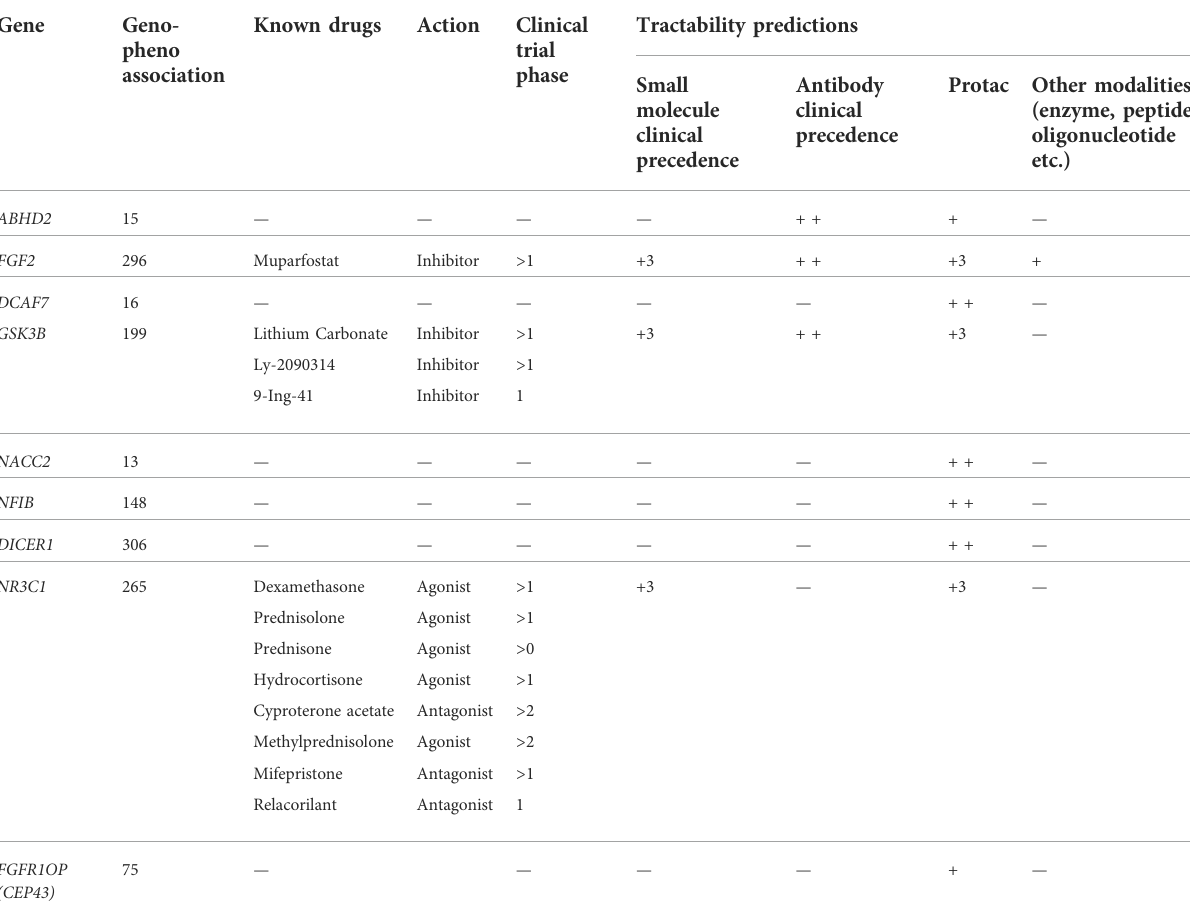
TABLE 5 Open Target Platform output for disease association, known drugs, action and clinical trial, tractability of 9 hub genes. Gene Geno- pheno